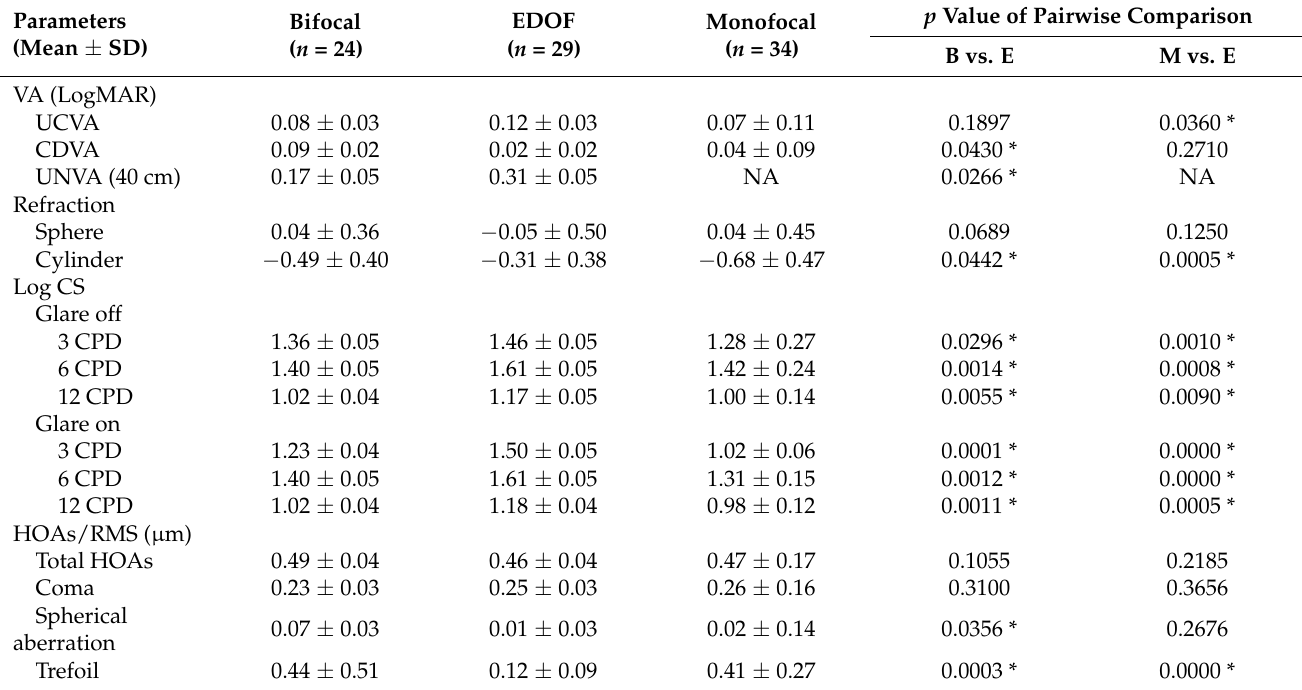
Table 3. Adjusted mean of postoperative visual acuity, mesopic contrast sensitivity, and higher-order aberrations among different IOL groups, and pairwise comparison with EDOF as